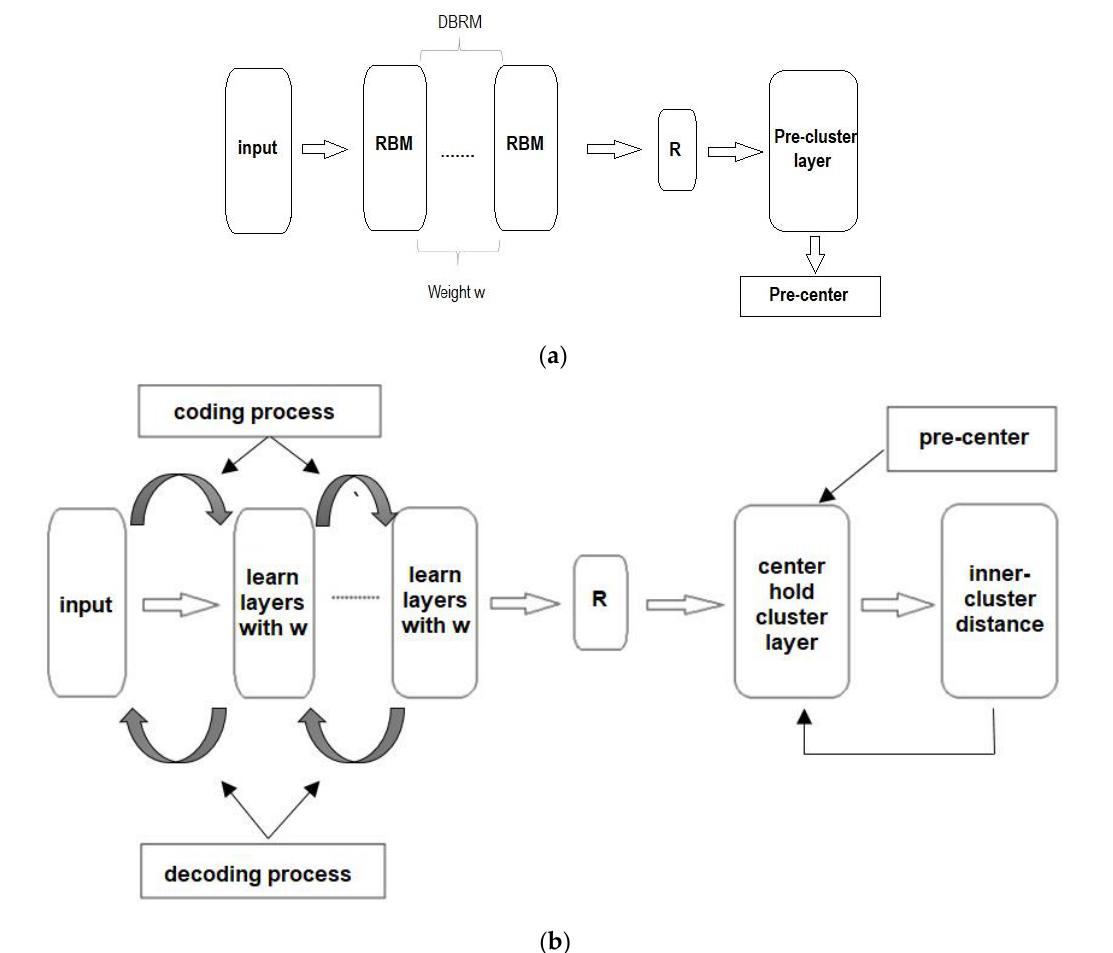
Figure 2. The overall structure of the DBN approach: ( a ) pre-training step of DBN, ( b ) fine-tuning step of DBN.